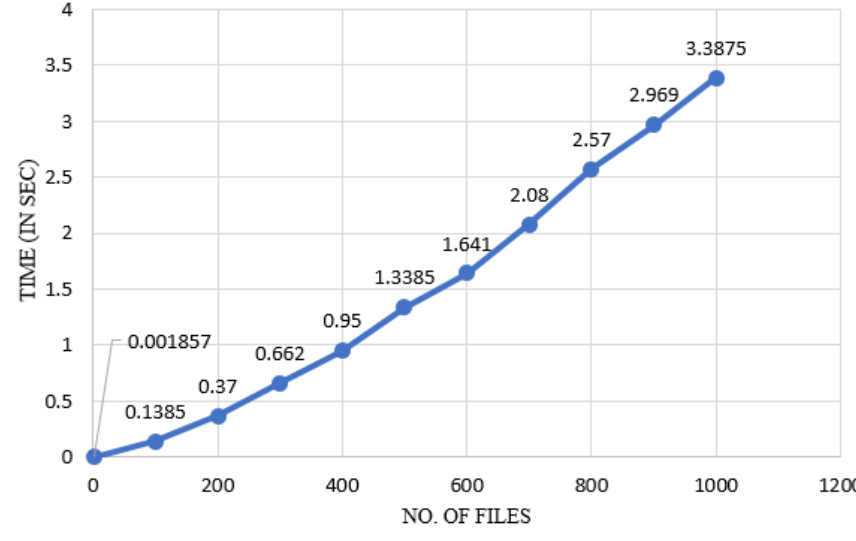
Figure 8. Root Extraction Time Graph.